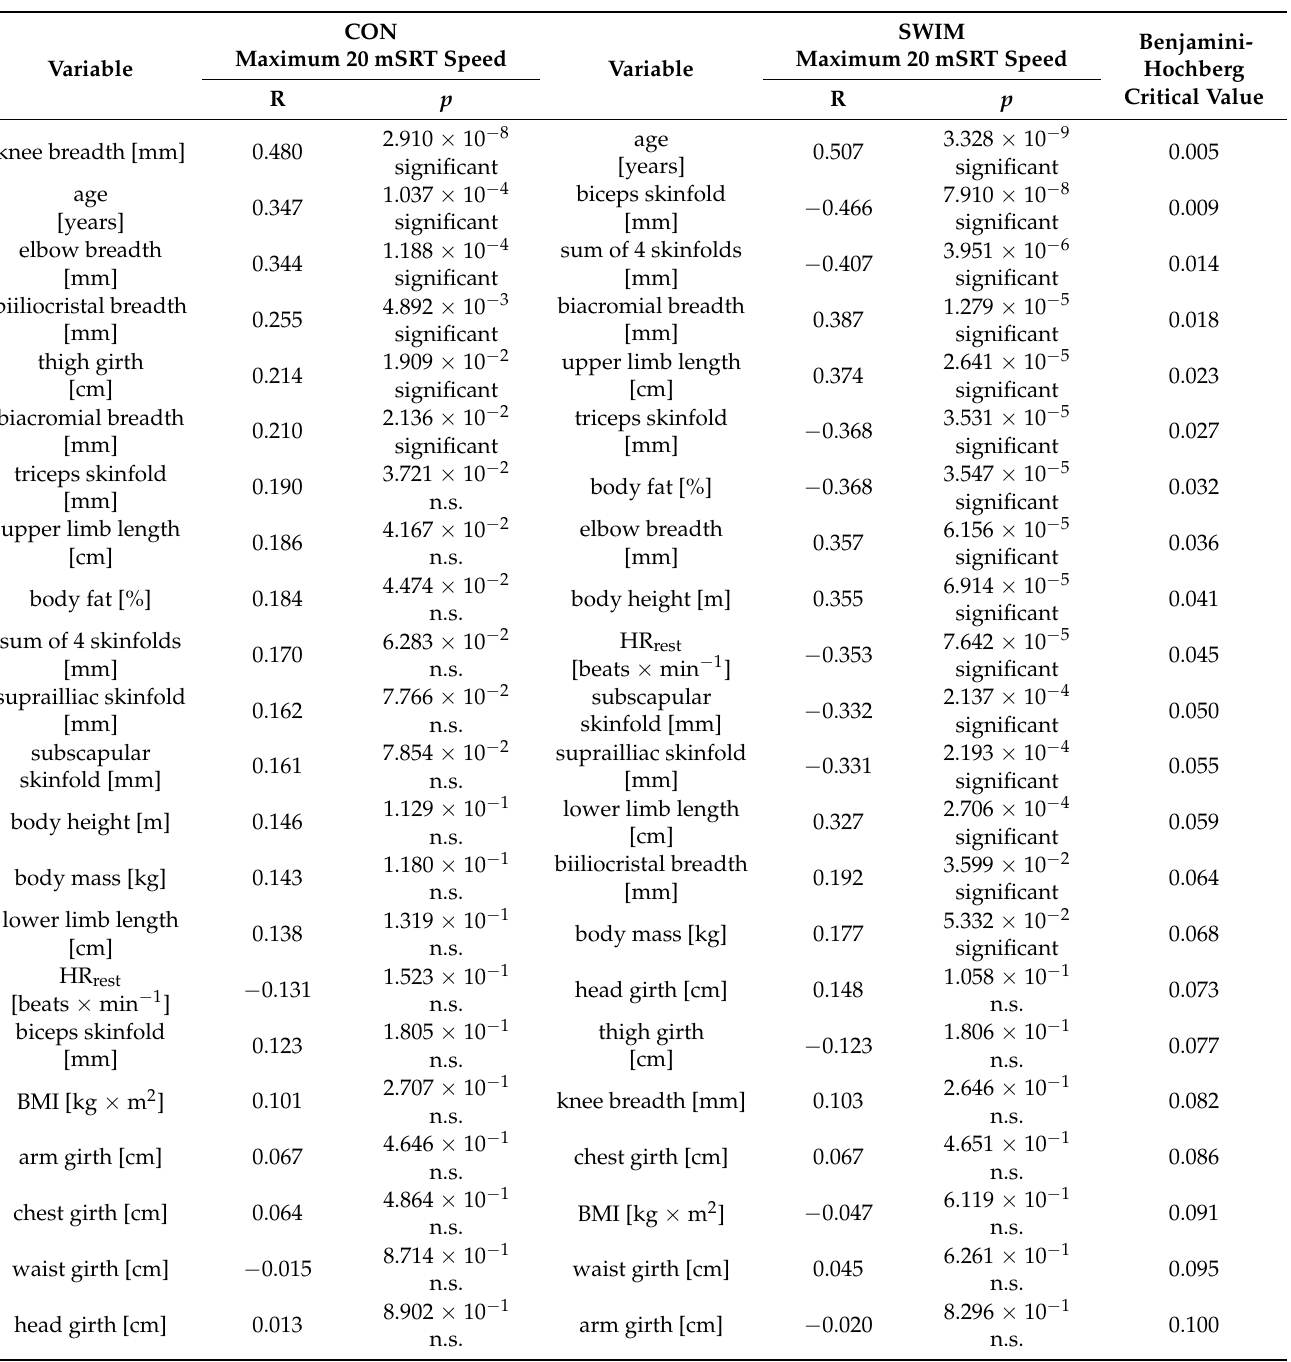
Table 3. Pearson’s correlation coefficients between the maximum 20 mSRT speed and biological variables for the control group (con; n = 120) and the experimental group (swim; n = 120) adjusted for the false discovery rate of